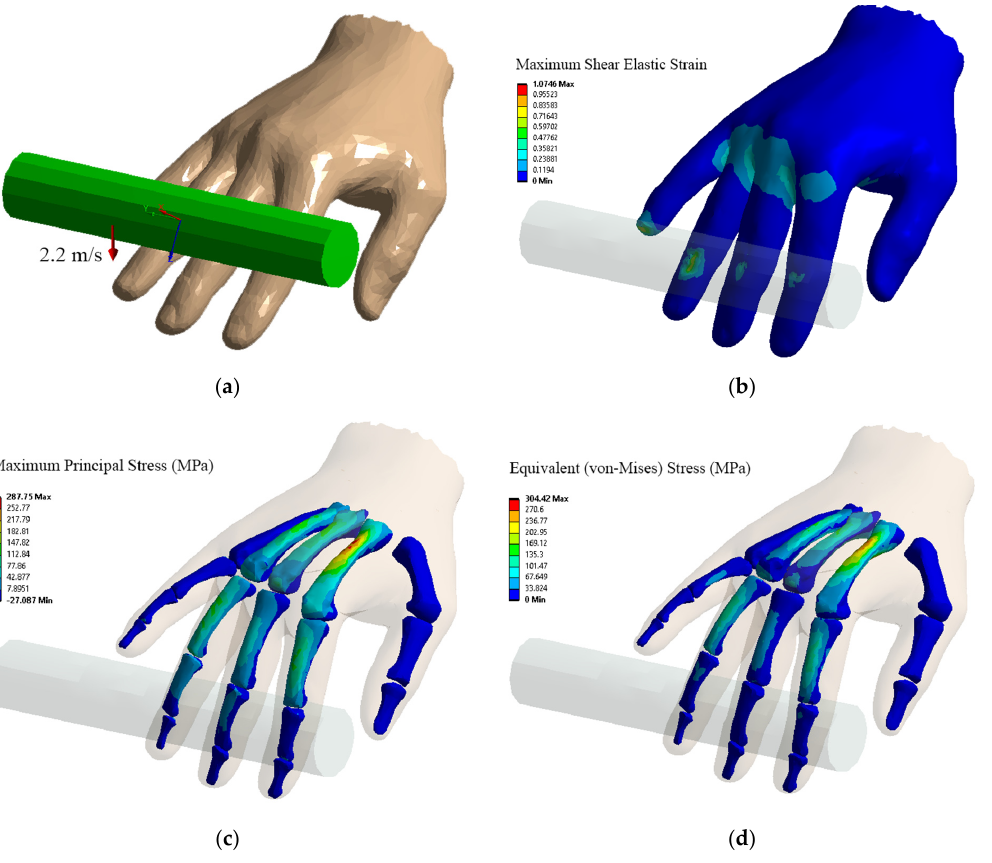
Figure 14. Impact of UR10 end effector at velocity of 2.2 m/s under flexion. ( a ) Impact Geometry, ( b ) Shear Elastic Strain, ( c ) Principal Stress, and ( d ) von-Mises Stress.